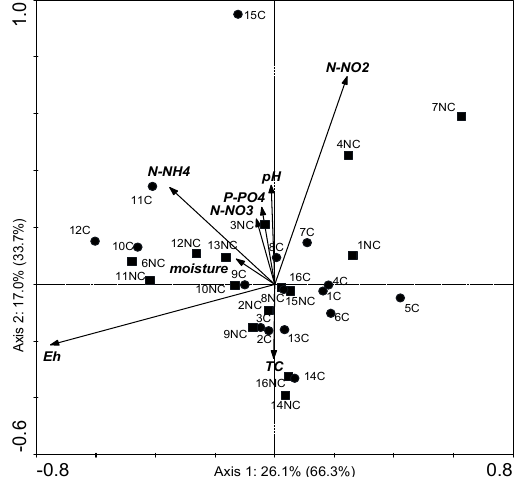
Figure 6. Biplots (CCA) along the two main axes of variation for the significant environmental variables ( p < 0.05) and sampled soils of DGGE banding patterns (NC—non-cultivated, C—cultivated). The number before C and NC indicates the number of the soil sample.